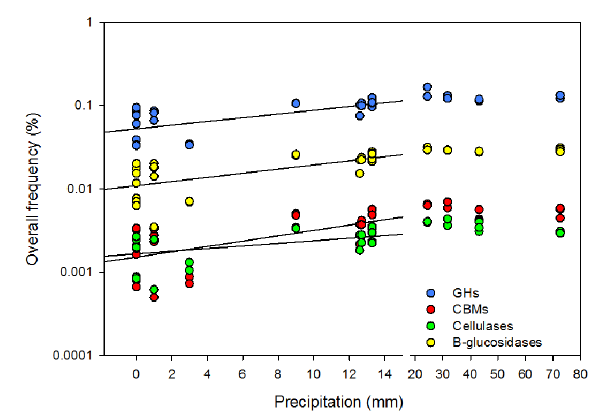
FIGURE 3 | Effect of the cumulative precipitation during the 2 weeks prior to litter collection on the overall rarefied frequency of microbial glycoside hydrolases (GHs), carbohydrates binding modules (CBMs), β -glucosidases, and cellulases. Break in the x -axis was introduced to discriminate low from high precipitation.